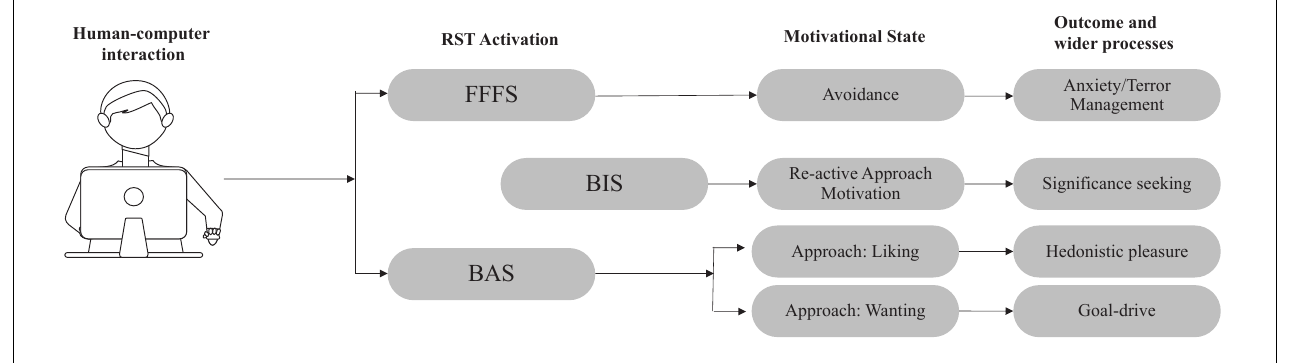
FIGURE 1 | Four motivational pathways toward and away from violent extremist action.